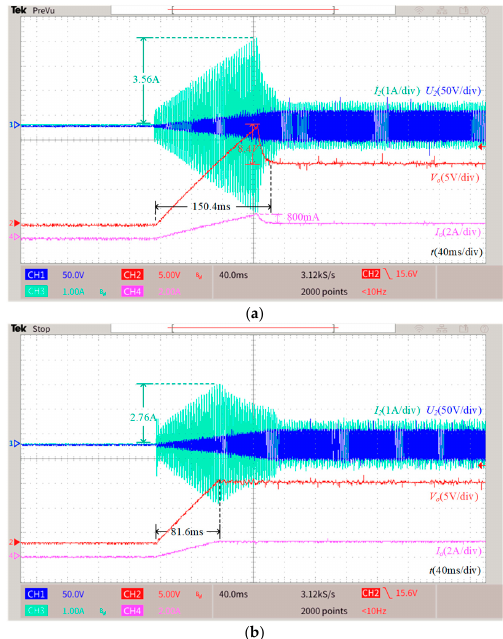
Figure 4. Tracking performance in Case 1 with resistance load, ( a ) PI control, and ( b ) FTSM-ELM control.